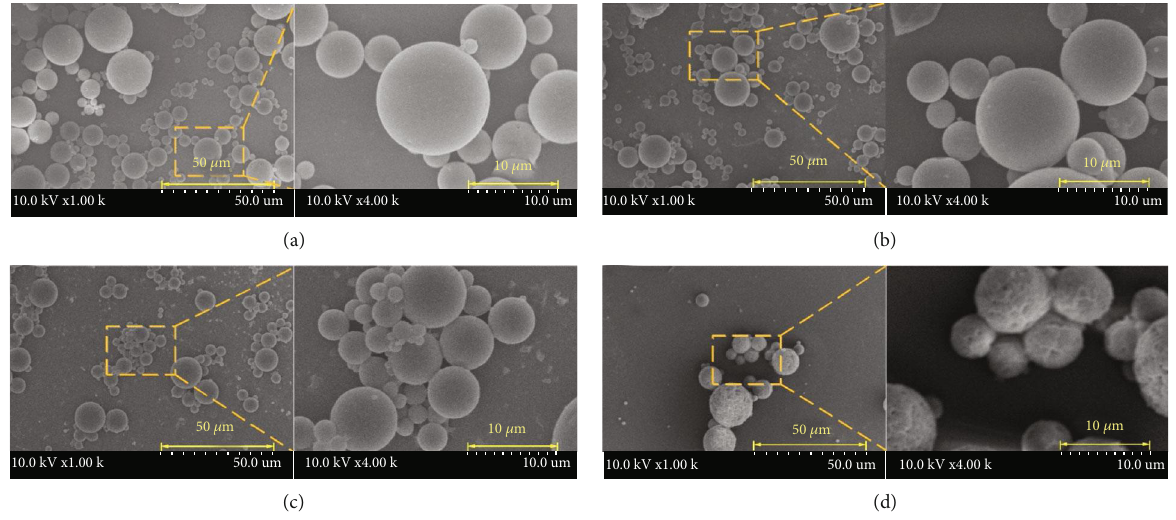
Figure 57: SEM micrographs of PU microcapsules: (a) S1, (b) S2, (c) S3, and (d) S4